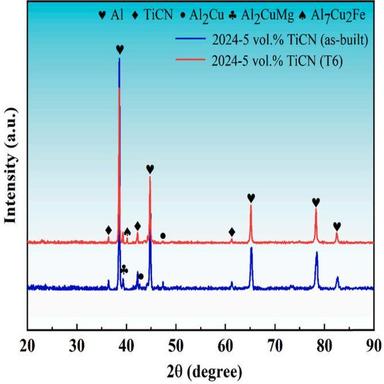
XRD patterns of the 2024-5 vol% TiCN before and after T6 heat treatment.